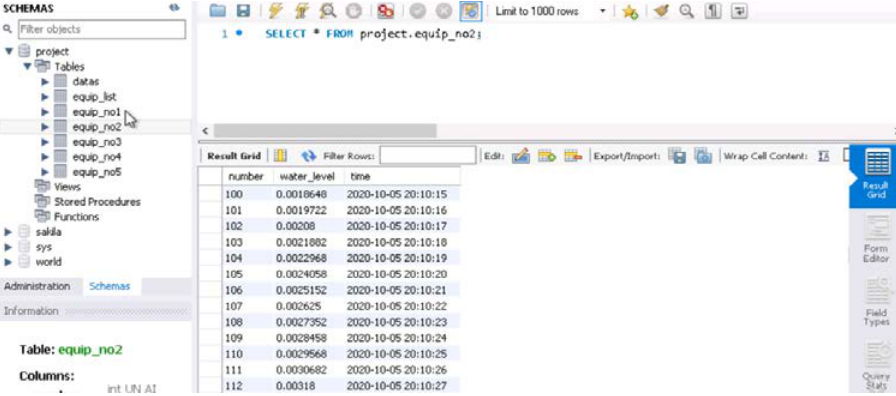
Fig. 3. Database terminal water level data